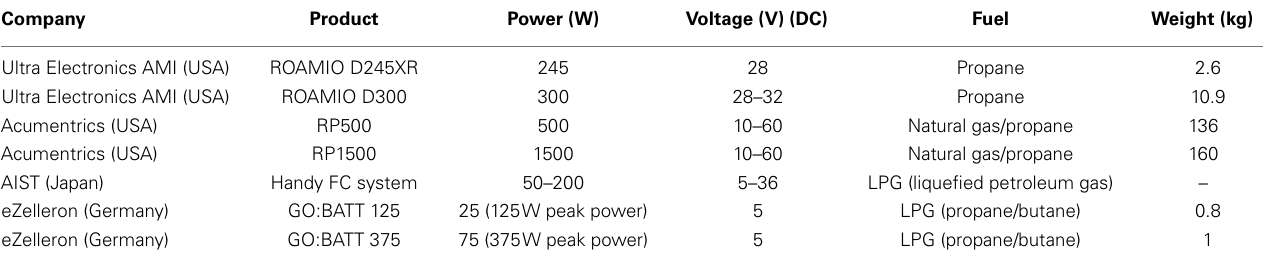
Table 1 | Summary of mT-SOFC based products fabricated by different companies .